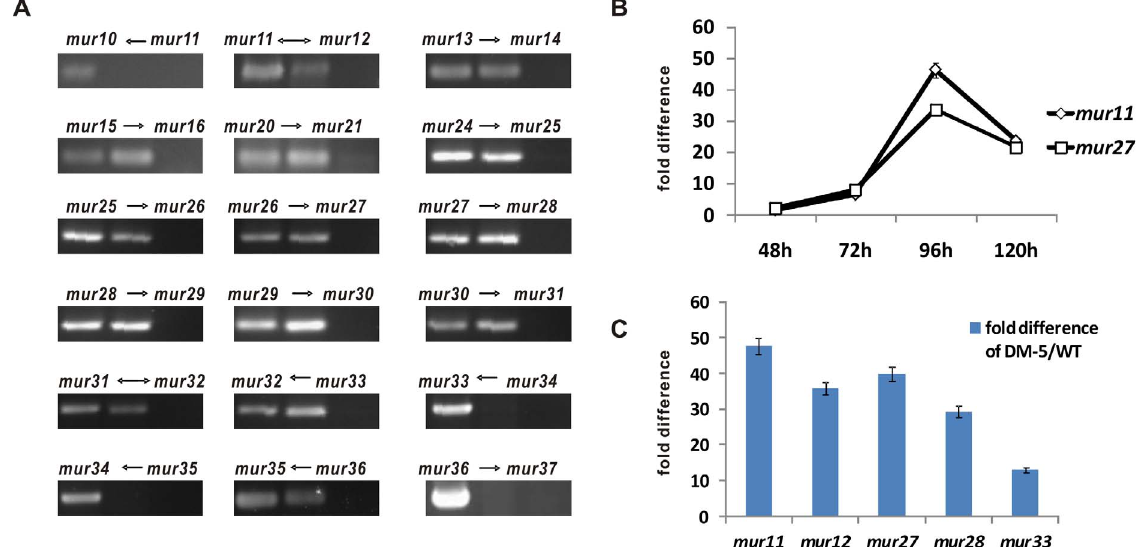
Figure 3. Gene expression analysis of the mur genes. (A) Transcription analysis of intergenic region of the selected mur genes. Top, ethidium bromide-stained agarose gels showing RT-PCR fragments from intergenic regions. mur10 r mur11 means that the detected region between mur10 and mur11 , and the arrows showed the possible orientation of transcription. In each gel, the left band was positive control using genomic DNA as template, the middle band showed the PCR sample using cDNA as template, the right band is negative control using template from total RNA sample digested with DNase I. (B) Time course of the transcription difference of mur11 and mur27 for DM-5 and the wild type strain. (C). The transcription difference of DM-5 and the wild type strain for 96 h incubation was used for the comparative